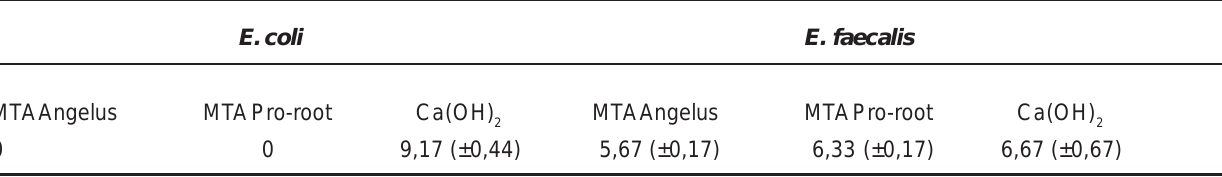
* Antimicrobial activity evaluated by agar diffusion method. Values represent the diameter (in mm) of zones of inhibition in mean of three experiments and standard